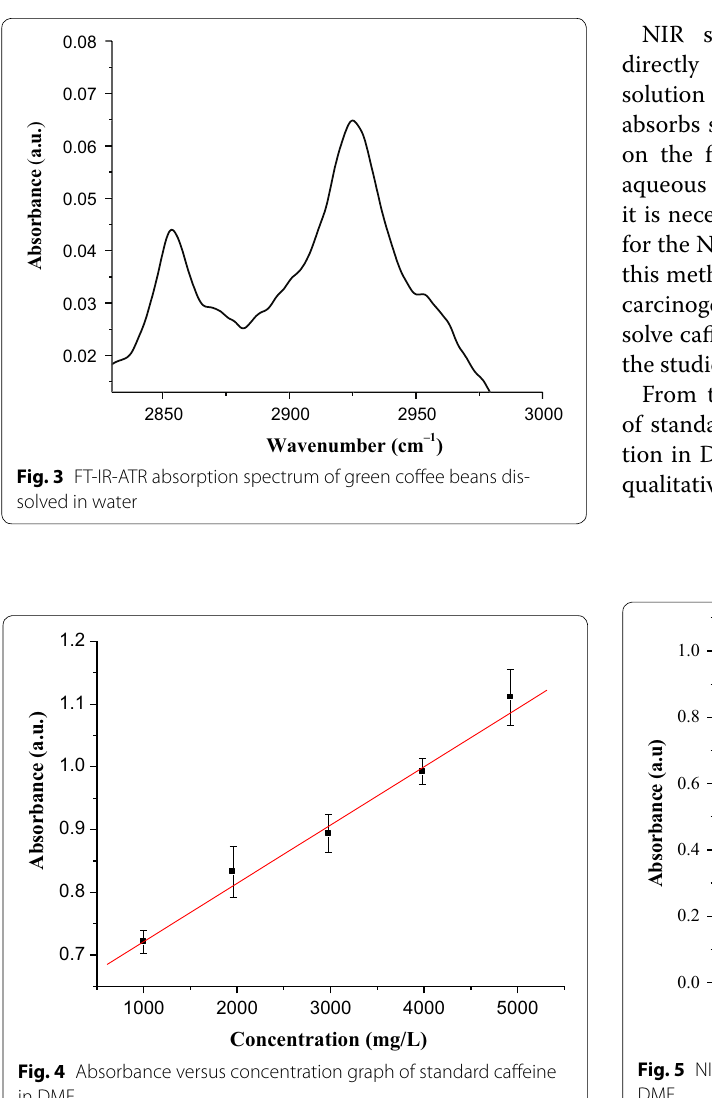
a The mass of the solution was measured to avoid any changes in the concentration which may results from the changes in the volume of the solution